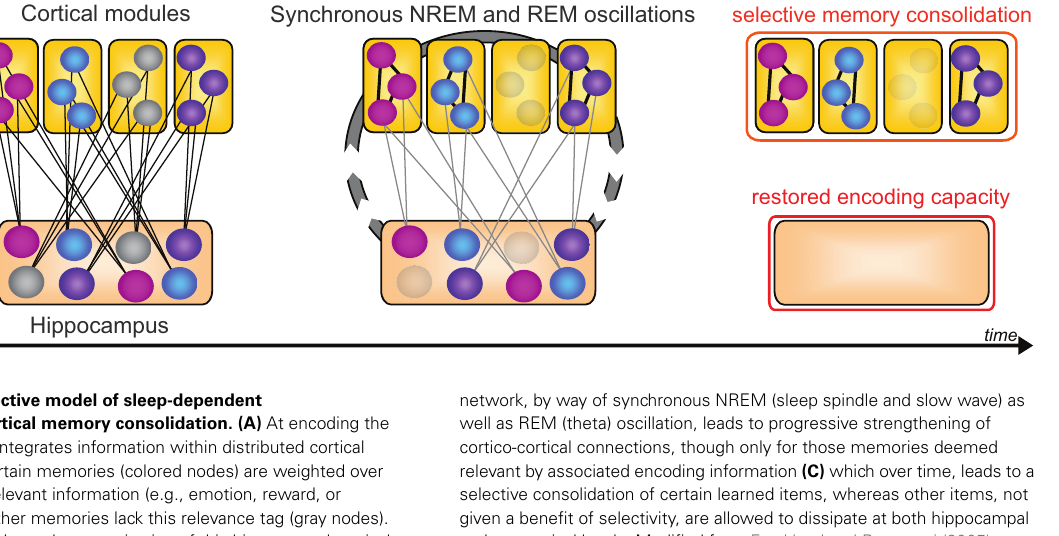
network, by way of synchronous NREM (sleep spindle and slow wave) as well as REM (theta) oscillation, leads to progressive strengthening of cortico-cortical connections, though only for those memories deemed relevant by associated encoding information (C) which over time, leads to a selective consolidation of certain learned items, whereas other items, not given a benefit of selectivity, are allowed to dissipate at both hippocampal and neocortical levels. Modified from Frankland and Bontempi